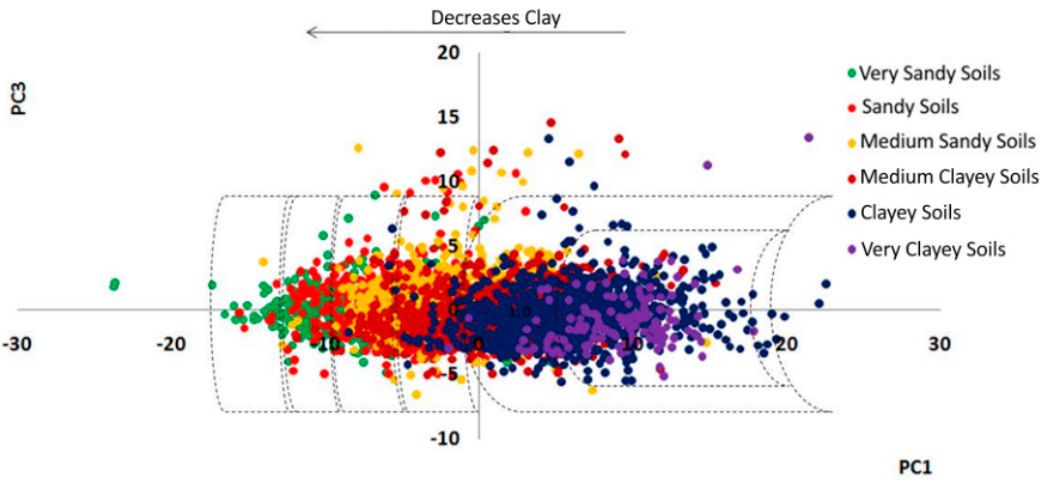
Figure 6. Scores chart of PC1 (Principal Component 1) vs. PC3 (Principal Component 3) showing the distribution of the studied soil samples, grouped by texture classes with sequential distribution along the spectrum.